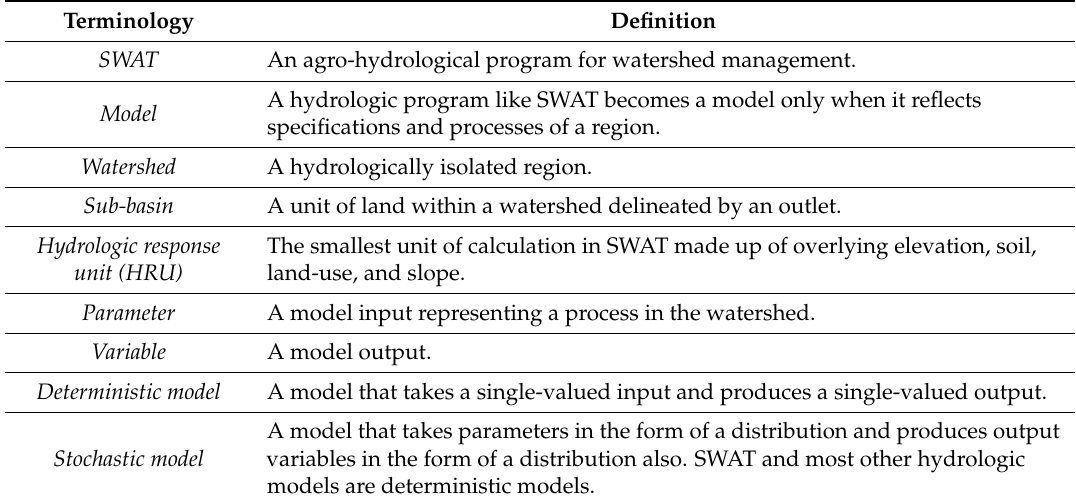
Table 1. Definition of some